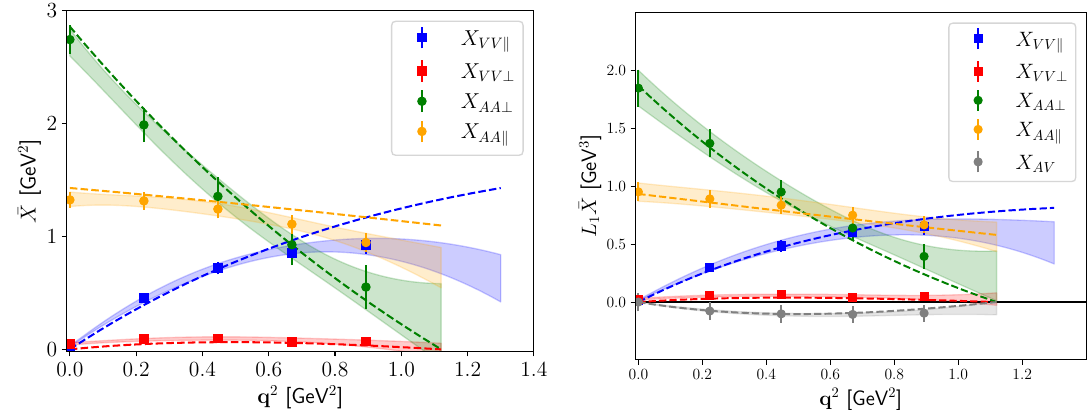
Figure 1 . ¯ X (left panel) and L 1 ¯ X (right panel, corresponding to the numerator of eq. (2.38)) as functions of q 2 . The results are shown for each channel. X AV is non-vanishing only for L 1 ¯ X . The dashed curves are the estimated contributions from the ground states of D s and D ∗